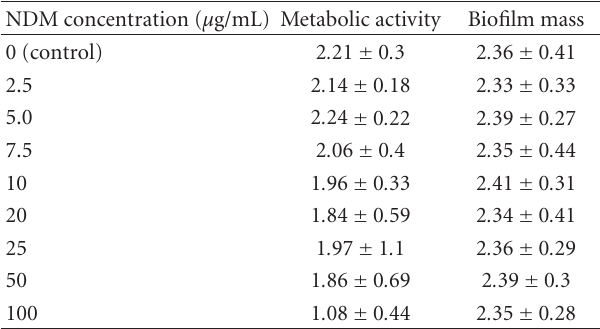
Table 2: E ff ect of cranberry NDM on preformed S. gordonii biofilm.